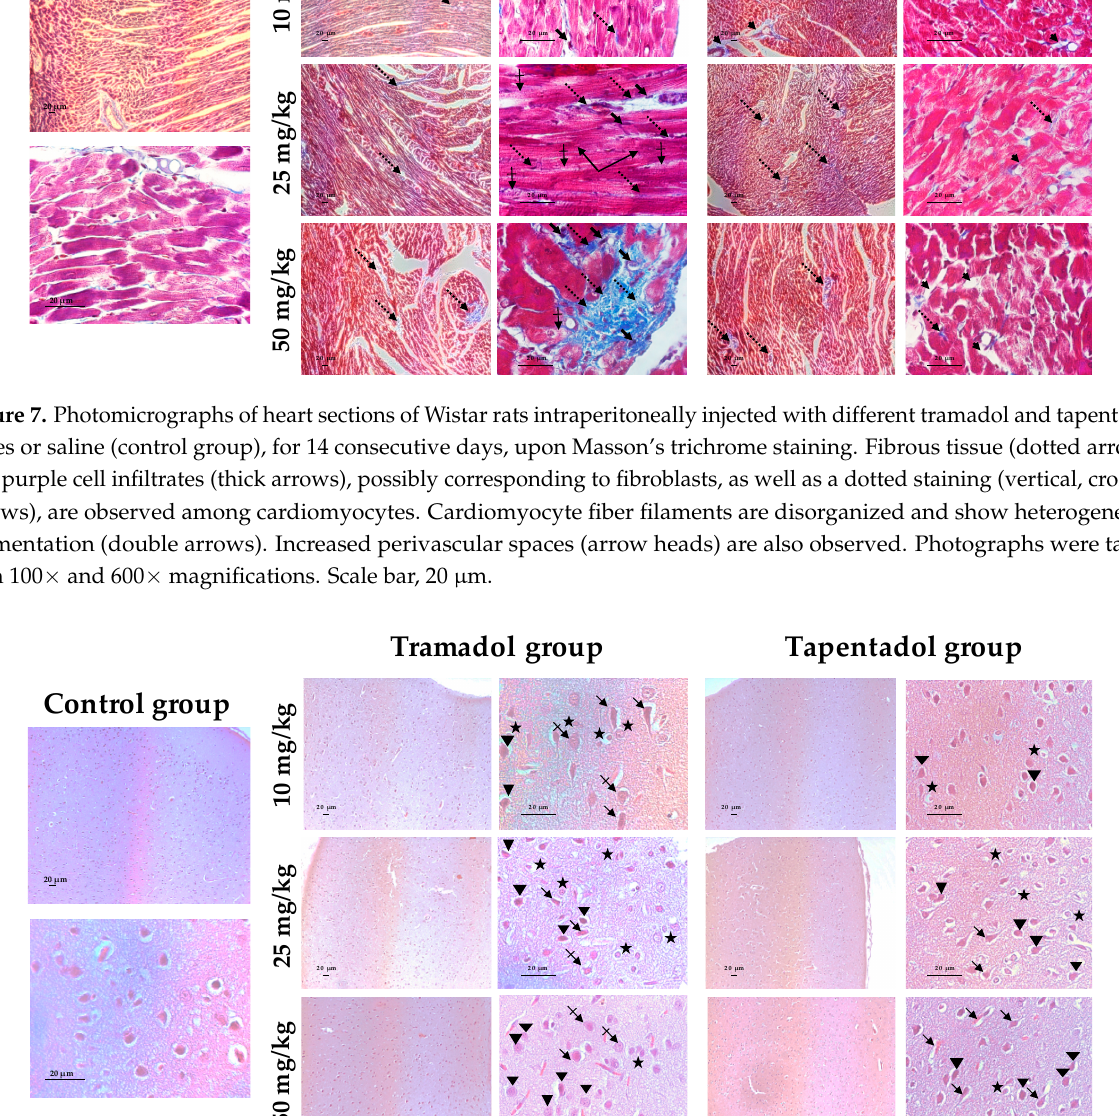
Figure 8. Photomicrographs of brain cortex sections of Wistar rats intraperitoneally injected with different tramadol and tapentadol doses or saline (control group), for 14 consecutive days, upon hematoxylin and eosin (H&E) staining. Glial and microglial cells are observed (stars), as well as swollen neurons (crossed arrows), irregularly-shaped neurons (inverted triangles) and degenerated neurons (long arrows). Photographs were taken with 100× and 600× magnifications. Scale bar, 20 μ m.